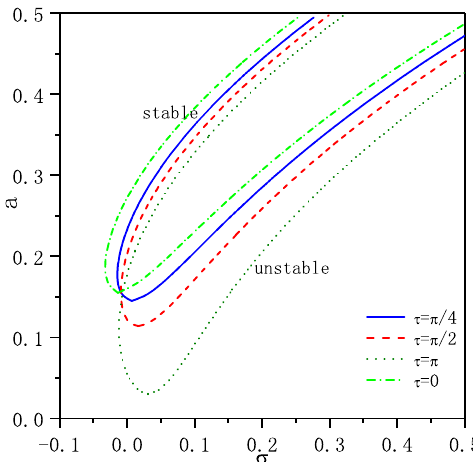
Figure 11. Subharmoic response for the nonlinear